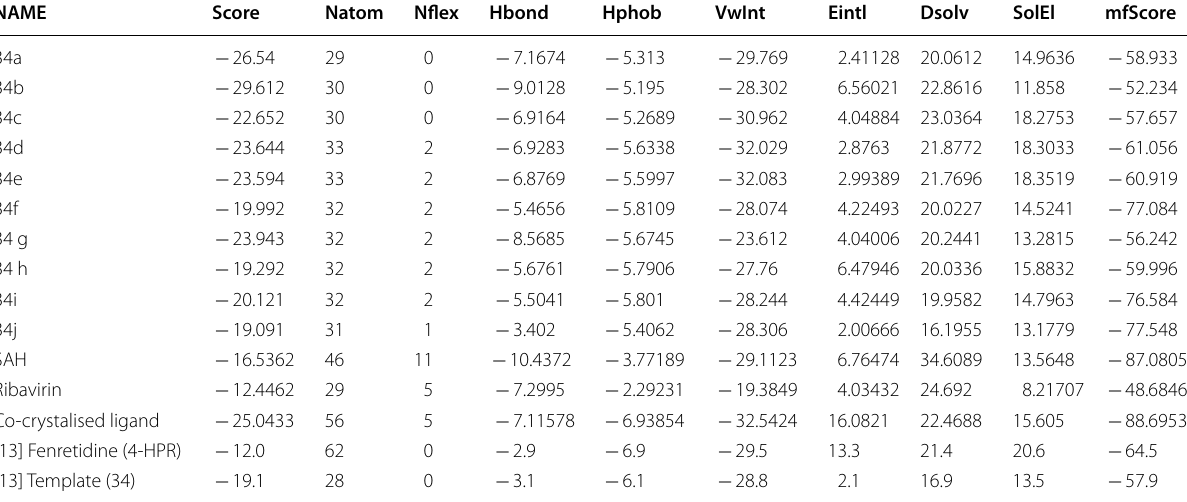
Table 2 Detailed illustration of the bonding interaction terms between the designed compounds and the